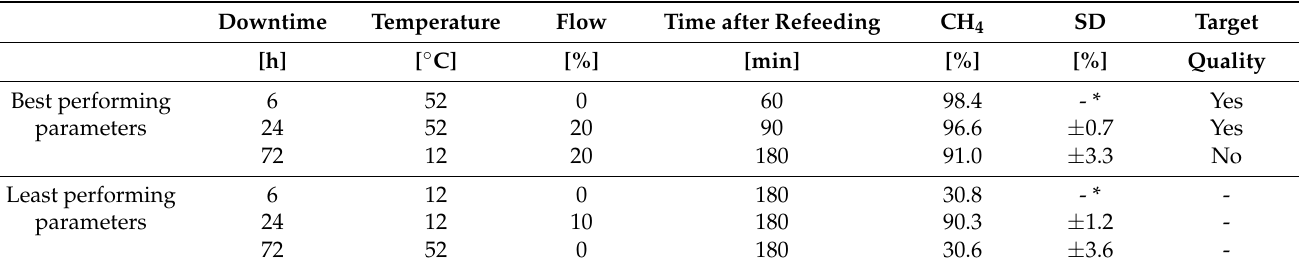
Table 1. An overview of the most and least efficient parameters for each downtime period. The most efficient parameters are determined as the fastest time to reach the target gas grid quality. If the target gas quality was not reached for the best performing parameters, the highest gas quality from the operational conditions was